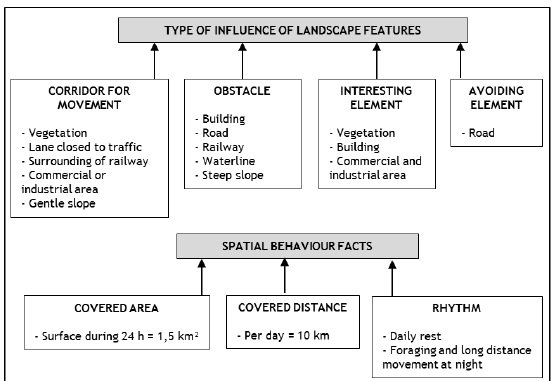
Figure 1. Knowledge on red fox movements in peri-urban environment and the influence of landscape